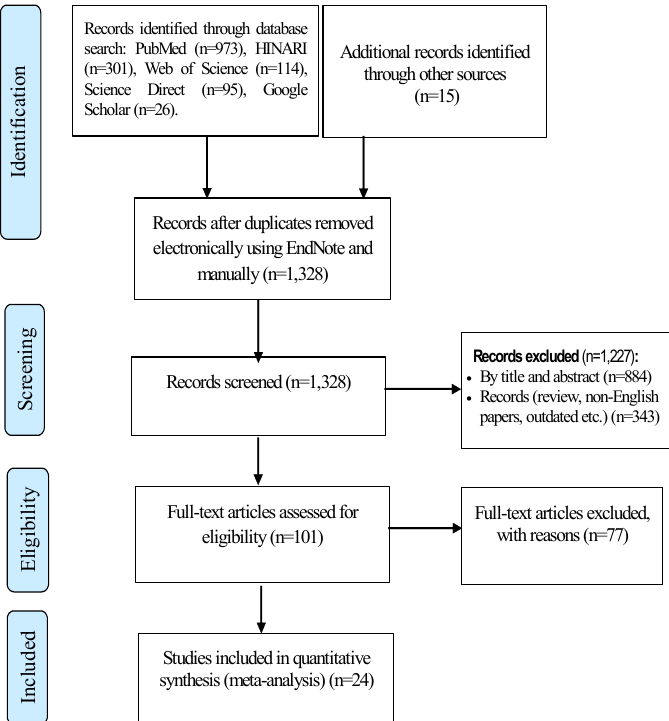
Figure 1. Flow chart of the study identification via databases, results of the search, and reasons for exclusion of articles.